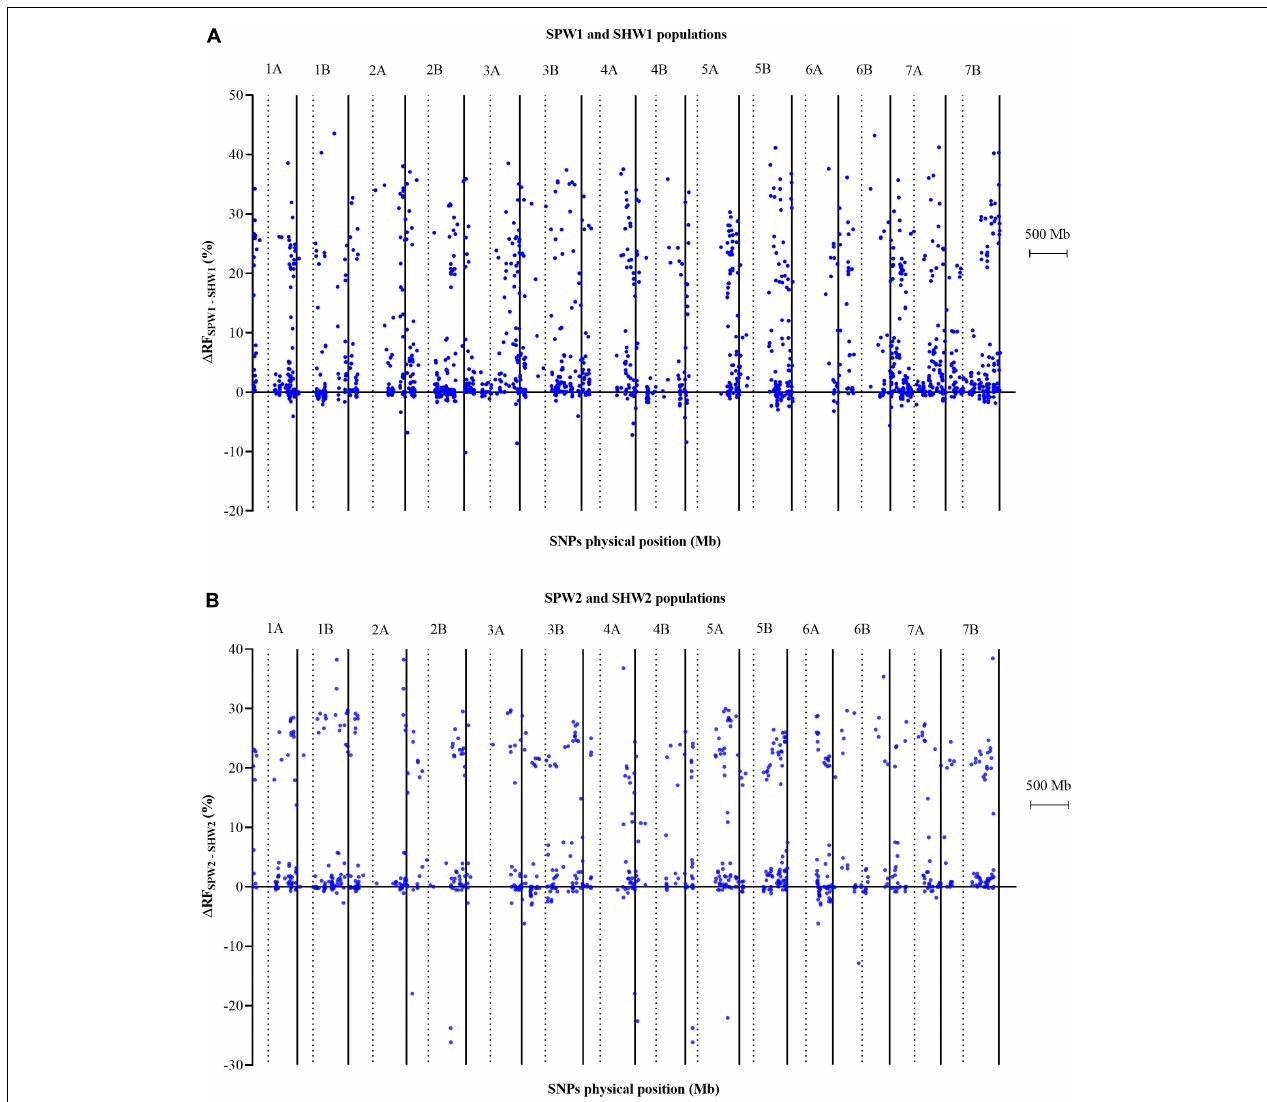
FIGURE 3 | Comparison of the variation in recombination frequency between adjacent and linked SNP loci in pentaploid and hexaploid populations. Dotted lines indicate the physical location of the centromere on each chromosome. (A) SPW1 and SHW1 populations. (B) SPW2 and SHW2 populations.